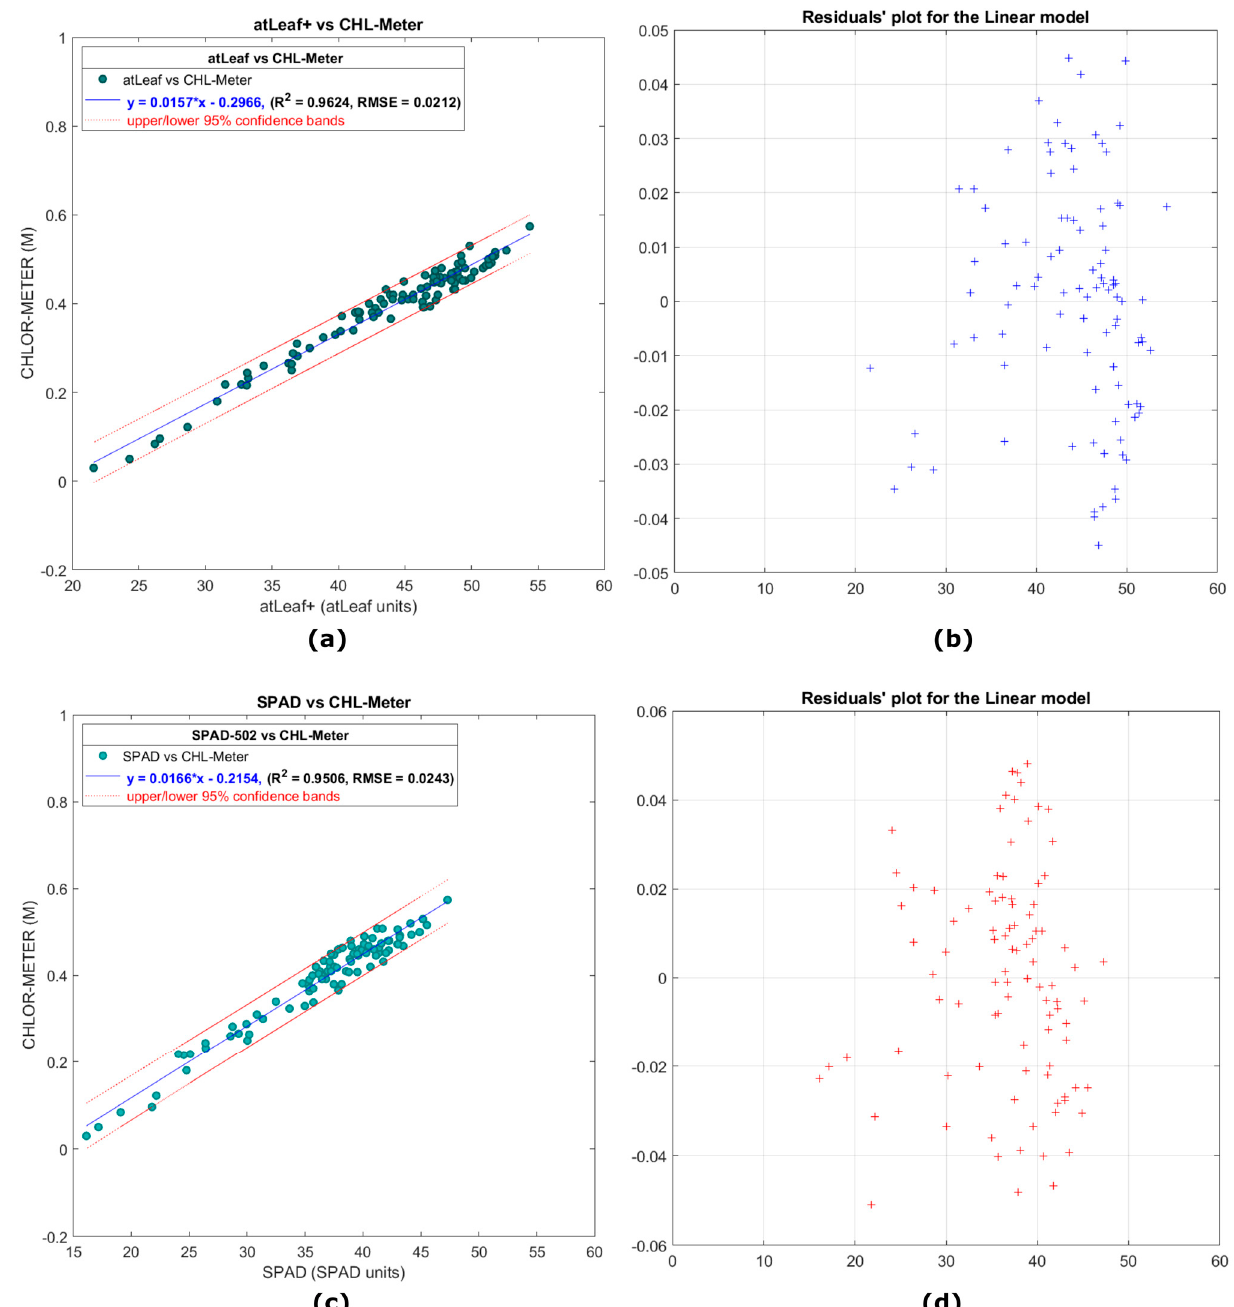
Figure 13. ( a ) A scatter plot showing the relation of data measurements with atLeaf CHL Plus as compared to the proposed sensor in this work, on 32 Russel’s cabbage leaves, while in ( c ) the relation with the SPAD-502 is shown for the same data measurements. In ( b , d ), plots of the residuals (marked with +) for the simple linear regression model fit in each case, applied on data and plotted on ( a , c ) are shown, respectively.